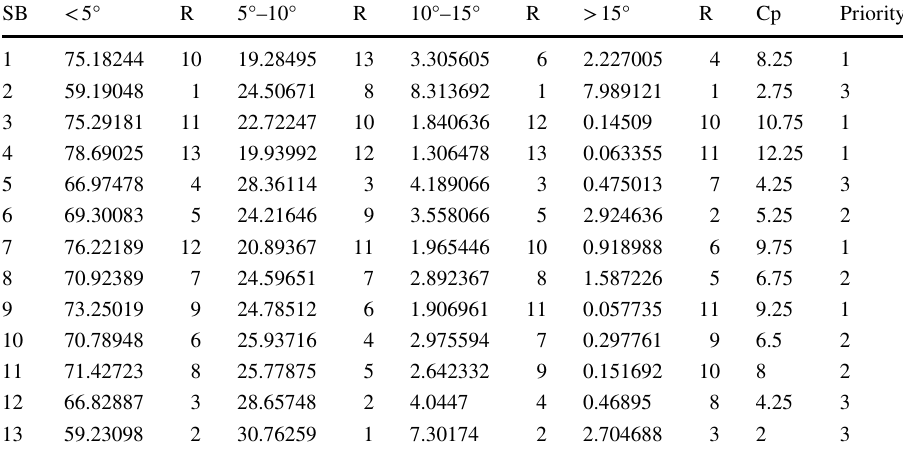
Table 9 Slope-based